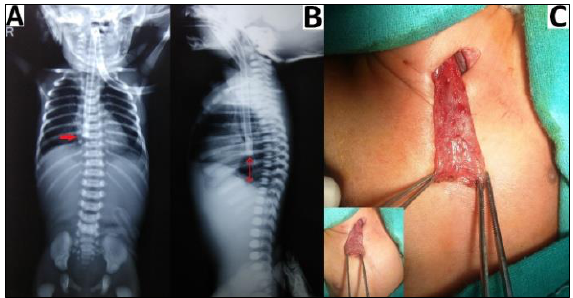
Figure 1: A,B) Preoperative chest radiographs (AP and lateral views; A and B) showing red rubber catheter in the esophagus arrested at the T8 vertebral level (red arrow) with absence of gas in the abdo- men, C)Operative pictures(with inset image) during esophagostomy showing dilated, long, colon like upper pouch.